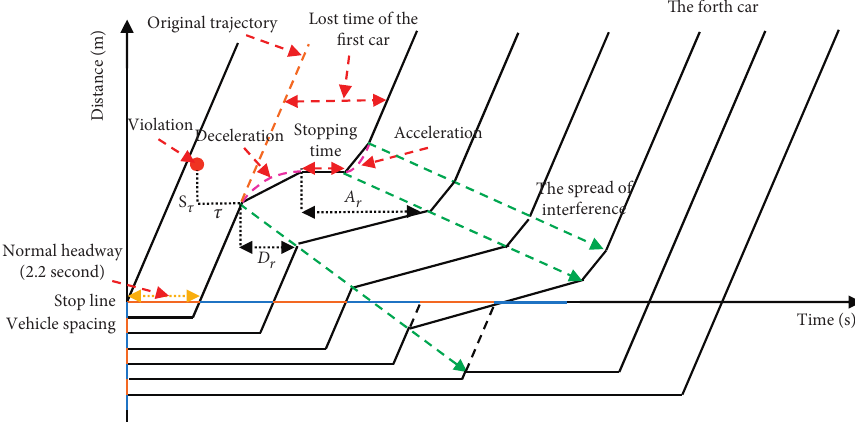
Figure 5: Vehicle trajectories affected by the violation.